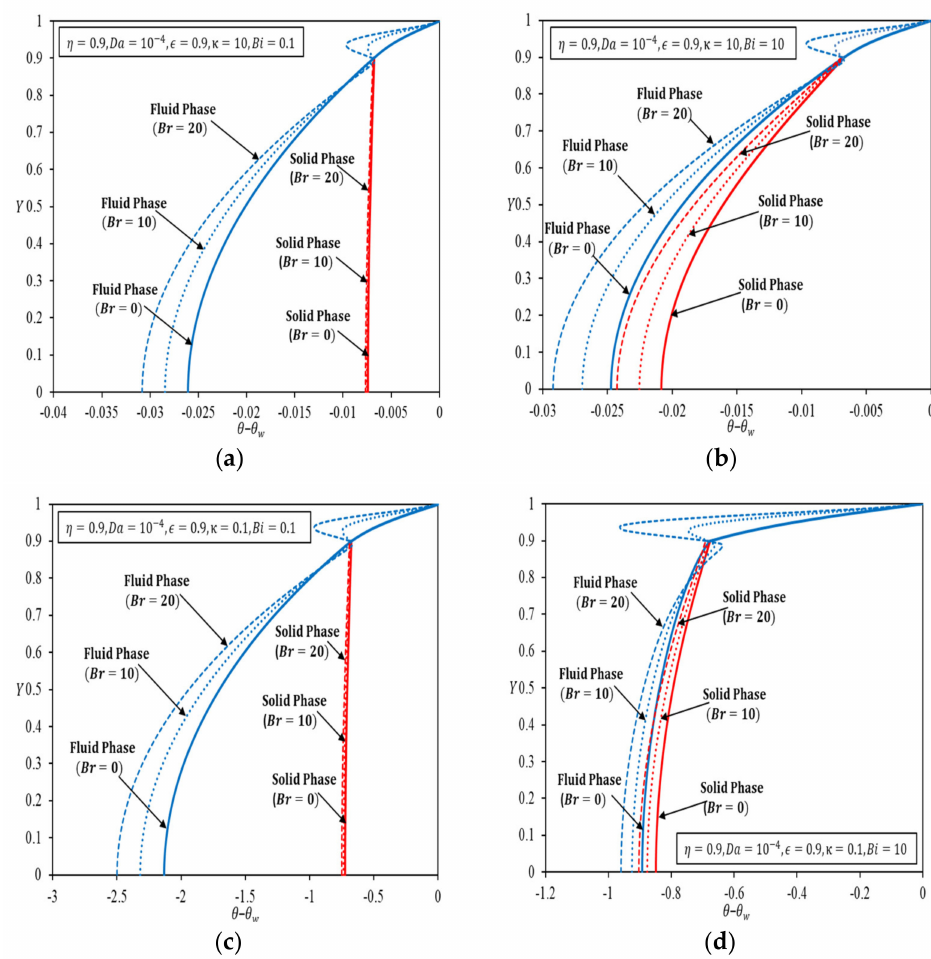
Figure 3. Temperature distributions for fluid and solid phases by having Br as a parameter for Da = 10 − 4 ( a ) κ = 10, Bi = 0.1; ( b ) κ = 10, Bi = 10; ( c ) κ = 0.1, Bi = 0.1; ( d ) κ = 0.1, Bi = 10. Table 2. Heat flux bifurcation for fluid and solid phases in porous region at interface η = 0.9. Br Da = 10 − 3 Da = 10 − 4 θ f ’ θ s ’ θ f ’ θ s ’ κ = 0.1, Bi =